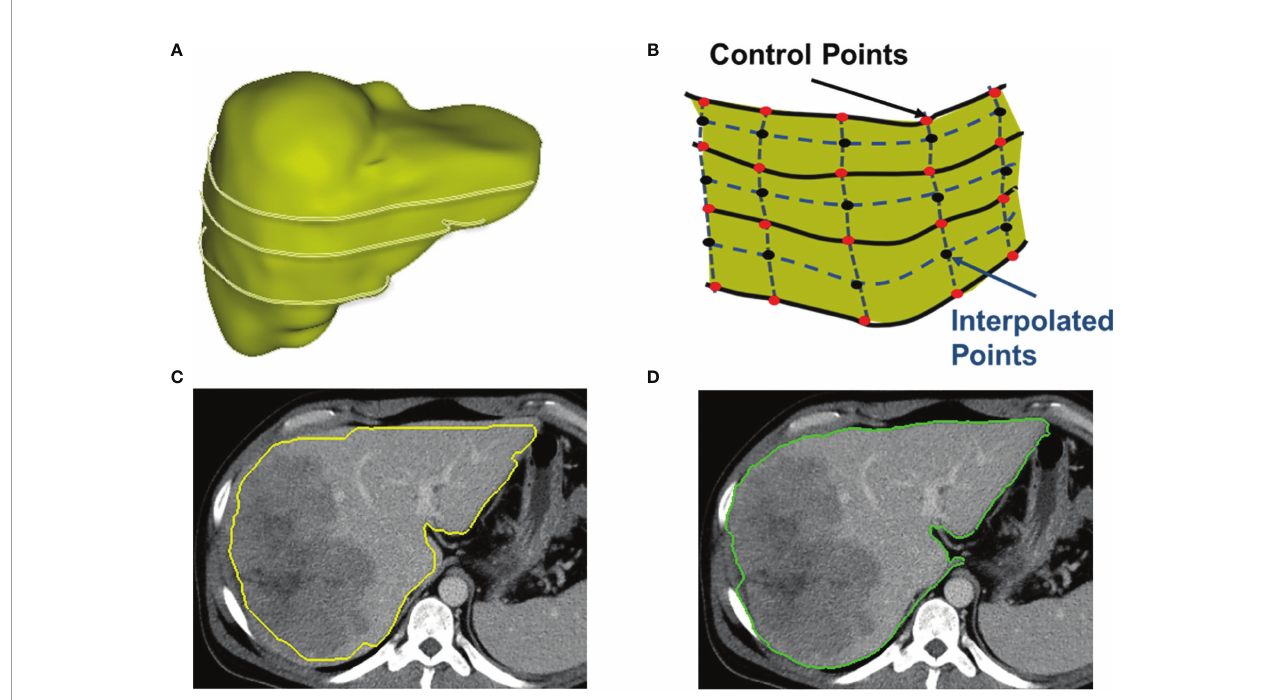
FIGURE 5 | Detection of between-slices contours by interpolation and optimization. (A) A 3D shape of a liver with contours on several non-adjacent key slices. CAC toolkit can detect the contours between key slices. (B) The interpolation of control points on slices between the key slices. (C) The initial contour estimated by using interpolated control points. (D) The resulting contour generated by the two-pass optimal path searching scheme using the estimated contour in (C)